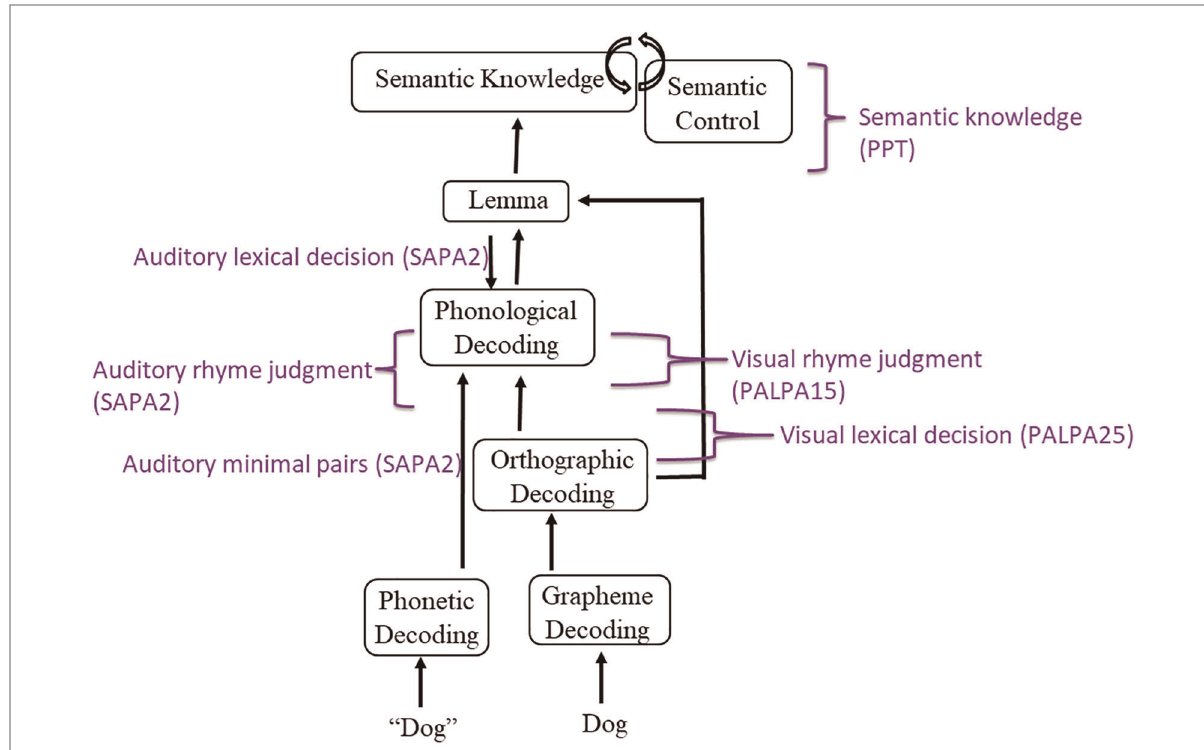
FIGURE 2 Model of receptive language and associated assessments. Model is informed by language processing models by Dell and colleagues (14), Foygel and Dell (34), and Indefrey and Levelt